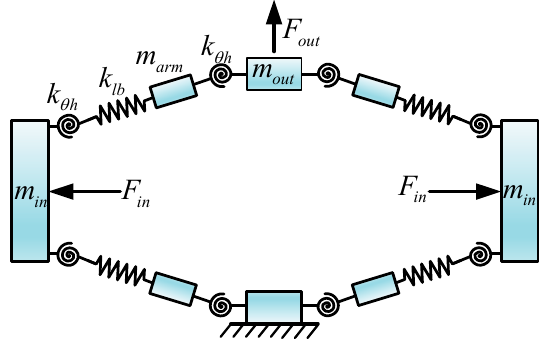
Figure 4. ( a ) Schematic diagram of the bridge ‐ type mechanism, ( b ) coordinate system of right ‐ angle flexure hinge.